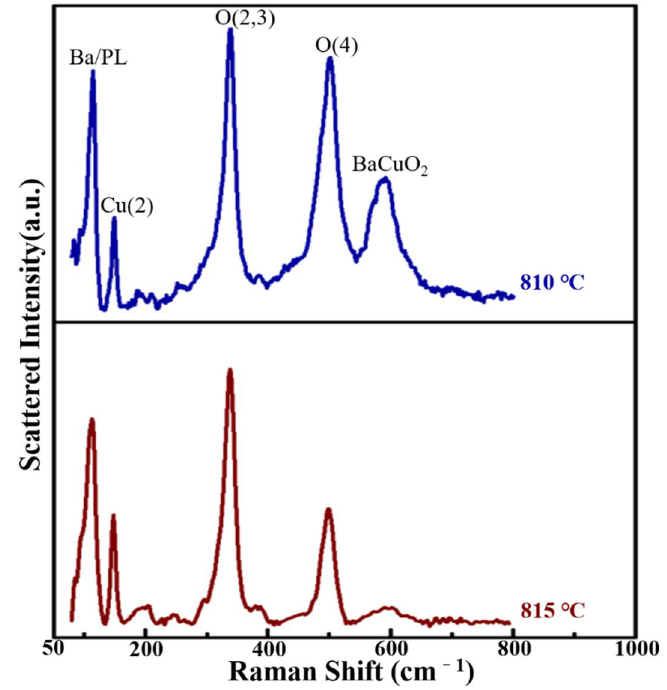
Figure 9. Raman spectra of low-vacuum pyrolysis films after high-temperature treatment. The superconducting transition characteristics curves of the samples at 815 °C are shown in Figure 10. At 815 °C, T c and the transition width of YBCO superconducting film are 89.2 K and 1.4 K, respectively. The above results demonstrate a purer superconducting phase has been achieved at 815 °C (Supplementary Figure S3) [21].